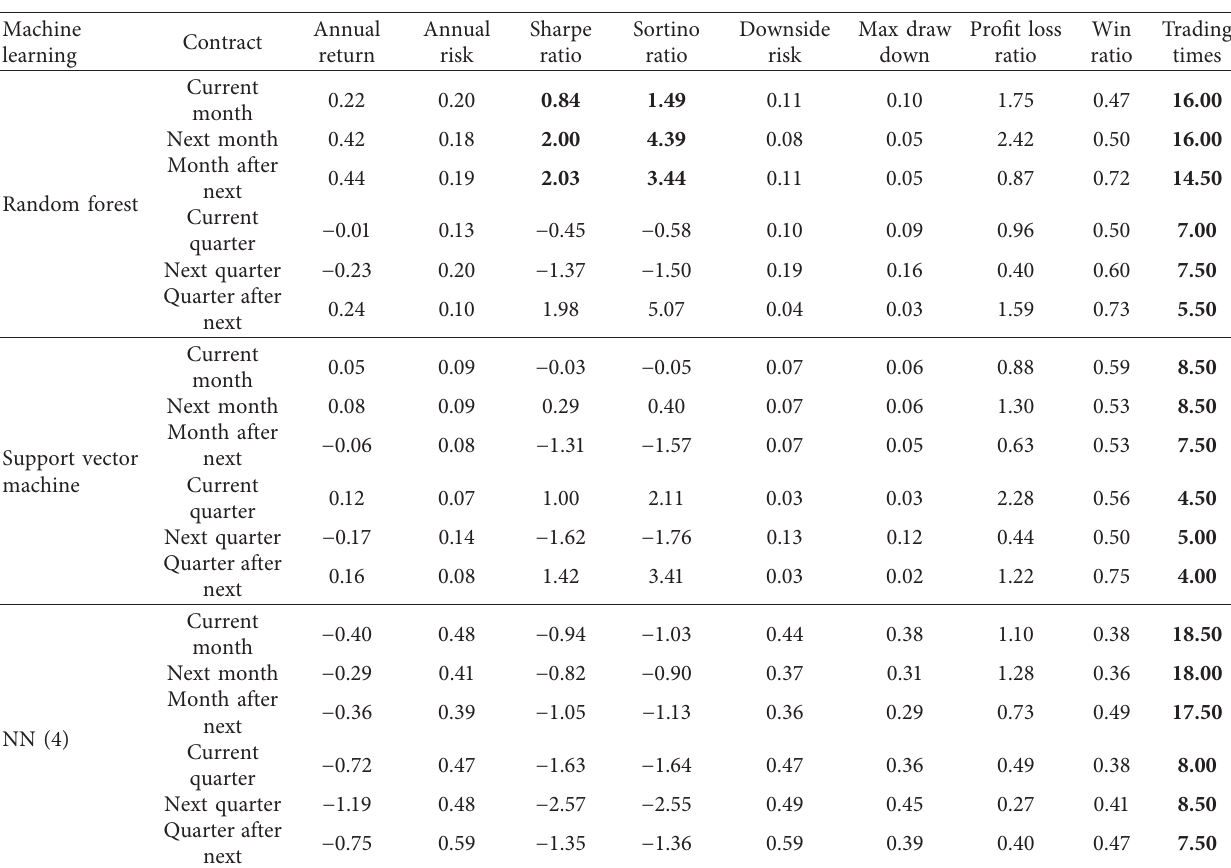
Table 11: Option strategy of predicting the rise and fall of volatility by threshold (use 8 features M1, threshold � 0.5).